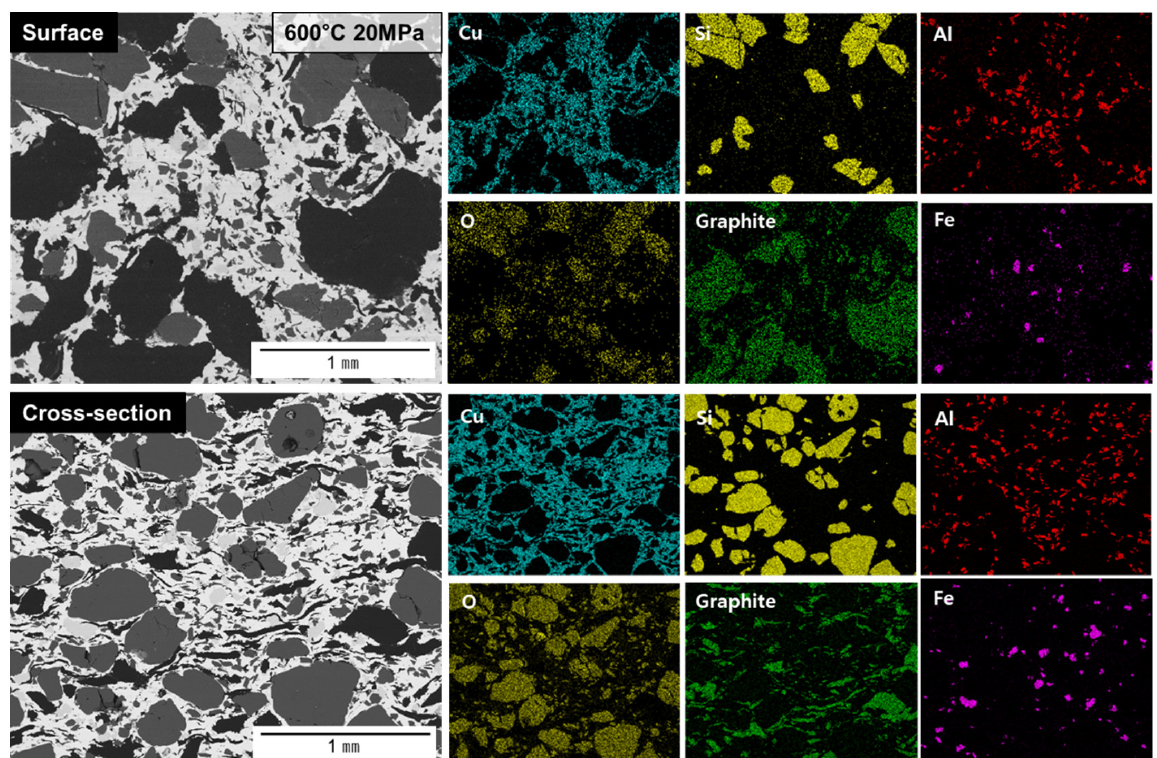
Figure 1. Backscatter electron (BSE) image and energy-dispersive X-ray spectroscopy (EDS) analysis results of surfaces and cross-sections of Cu-based 600-20 brake pad.